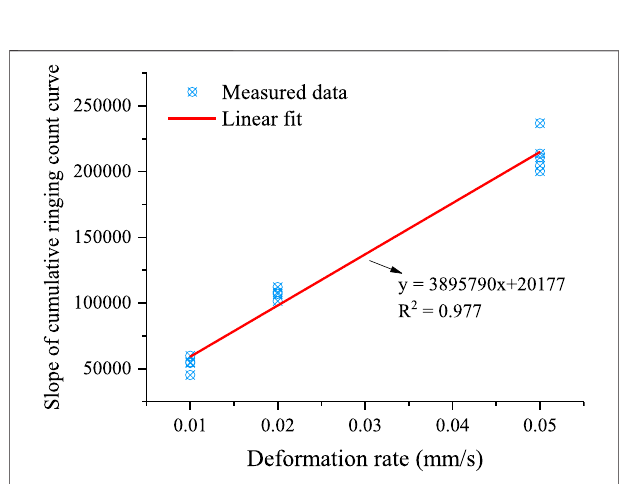
FIGURE 11 | Linear relationship between deformation rate and slope of cumulative ring down count.